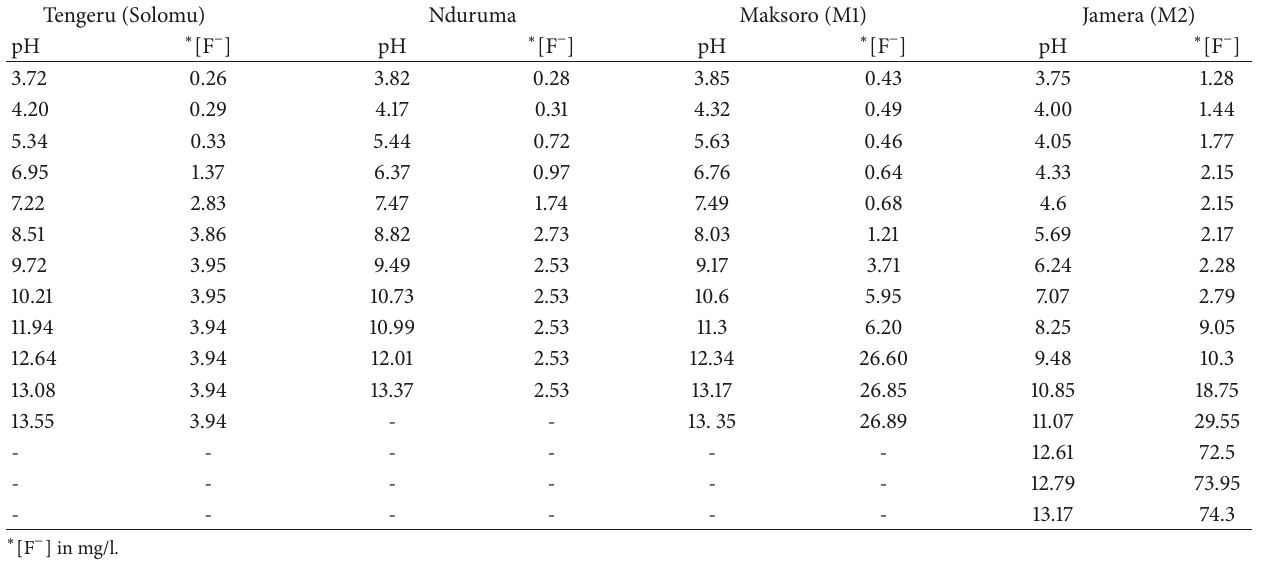
Table 6: The pH dependence of fluoride leaching from igneous rocks at 25 ∘ C. Tengeru (Solomu)